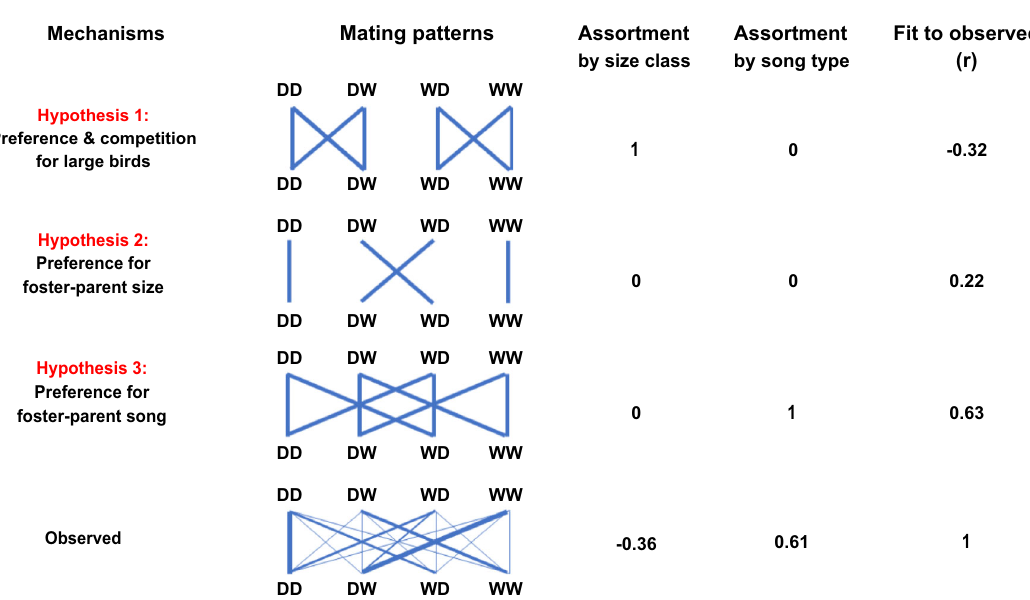
Fig. 4 Expected versus observed mating patterns in the cross-fostered Generation 2. The fi rst column indicates three a priori hypotheses (1, 2, 3) and the observed mating pattern ( N = 147 nesting pairs). The second column shows mating patterns between four types of females (top) and males (bottom): DD, DW, WD, WW (the fi rst letter indicates the genetic population of origin, the second letter indicates the population of the rearing parents; see Fig. 3). The thickness of the blue lines corresponds to the numbers of expected or observed pairs of each male-female combination. The smaller font size for wild- derived birds illustrates their smaller body size. The third and fourth columns show the expected or observed overall correlation between partners with regard to their size category (large D or small W) and song type (D or W, as learnt from foster parents). The last column shows the Pearson correlation coef fi cient between expected and observed numbers of pairs across the 16 pair combinations. See also Supplementary Fig. 7 for post-hoc combinations of multiple hypotheses explaining the observed data.